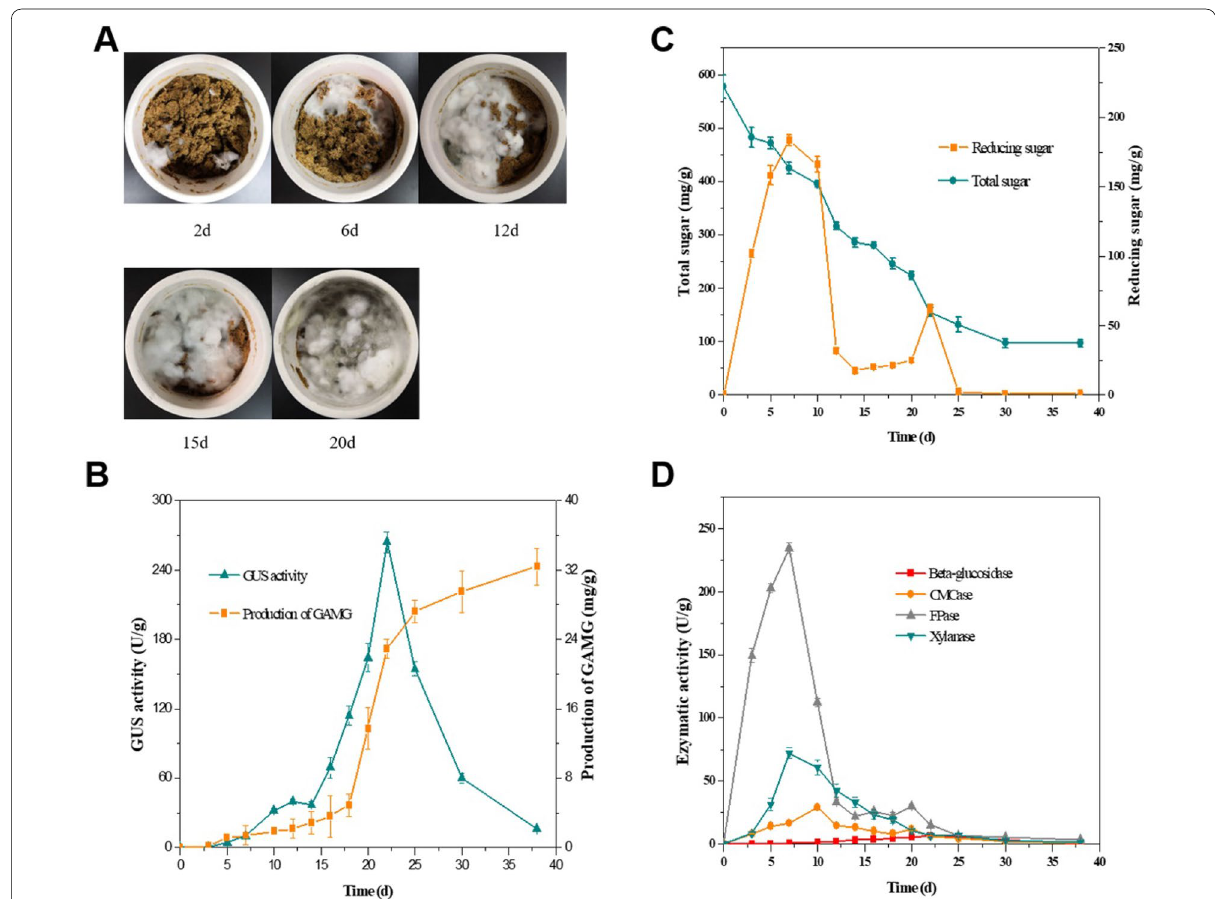
Fig. 3 GUS activity, GAMG, reducing sugar, total sugar, and lignocellulose-degrading enzymatic activity profiles of C. globosum DX-THS3 under optimal SSF conditions. A C. globosum DX-THS3 was grown on licorice straw for depth fermentation. B GUS activity and yield of GAMG profile; C reducing sugar and total sugar profile; D CMCase, FPase, β-glucosidase, and xylanase